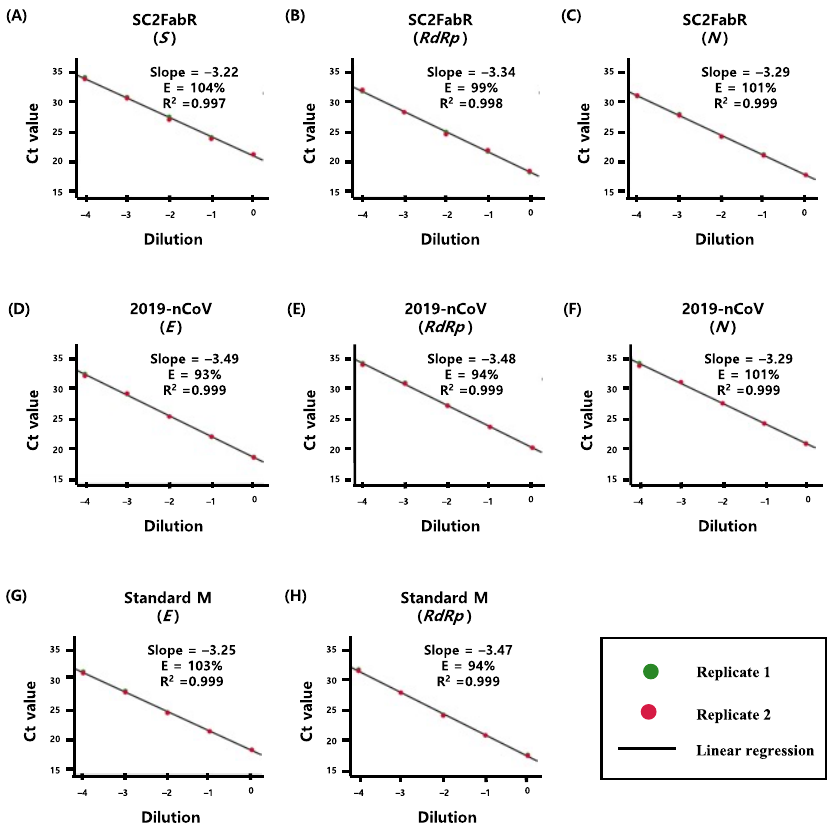
Figure 1. Comparison of the PCR efficiency of three assays [SC2FabR ( A – C ), 2019-nCoV ( D – F ), and Standard M ( G , H )] for SARS-CoV-2 detection. The PCR efficiency ( E ) of the amplification of each target gene was assessed using duplicate 10-fold dilution series of SARS-CoV-2 viral RNA. Linear regression analysis was performed using the SPSS software to obtain the slope and R 2 value. The percentage efficiency was calculated from the slope using the formula E = 100 × ( − 1 + 10 −1/slope ). S , gene encoding the spike protein of SARS-CoV-2; E , gene encoding the envelope protein of SARS-CoV-2; RdRp , gene encoding the RNA-dependent RNA polymerase of SARS-CoV-2; N , gene encoding the nucleocapsid protein of SARS-CoV-2; RT-PCR, reverse-transcription PCR; SARS-CoV-2, severe acute respiratory syndrome coronavirus 2.